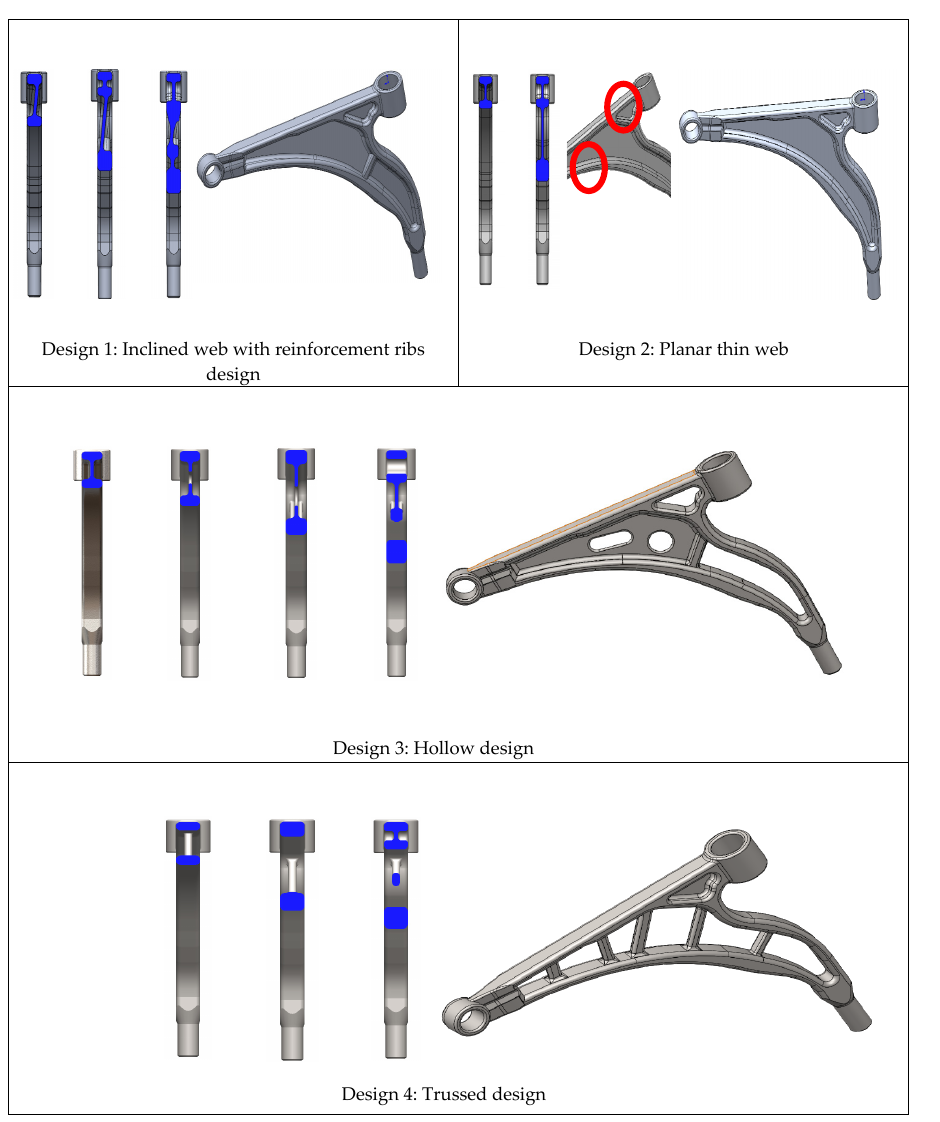
Figure 6. Modified design proposed for automotive mechanical suspension control arm